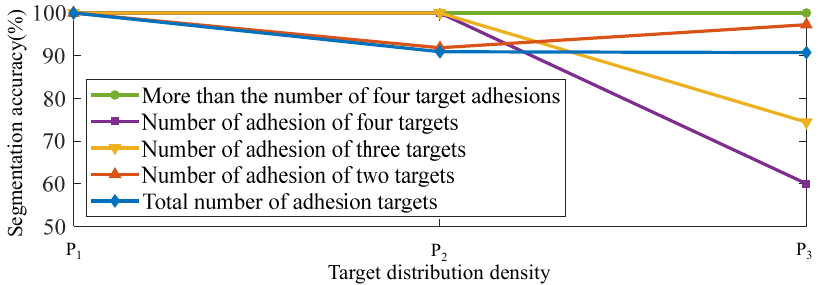
Figure 16. Accuracy of image segmentation.